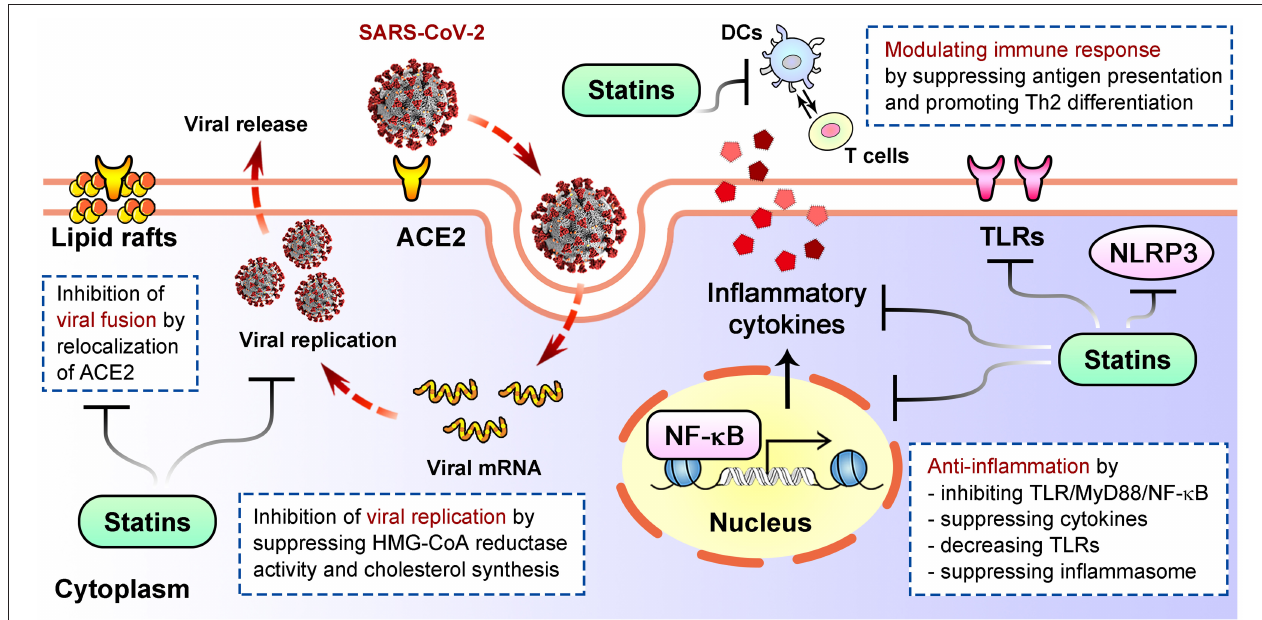
FIGURE 2 | Well established mechanisms of how statins inhibit viral life cycle, alleviate inflammation and modulate immune response after infection. DCs, dendritic cells; TLRs, Toll-like receptors.